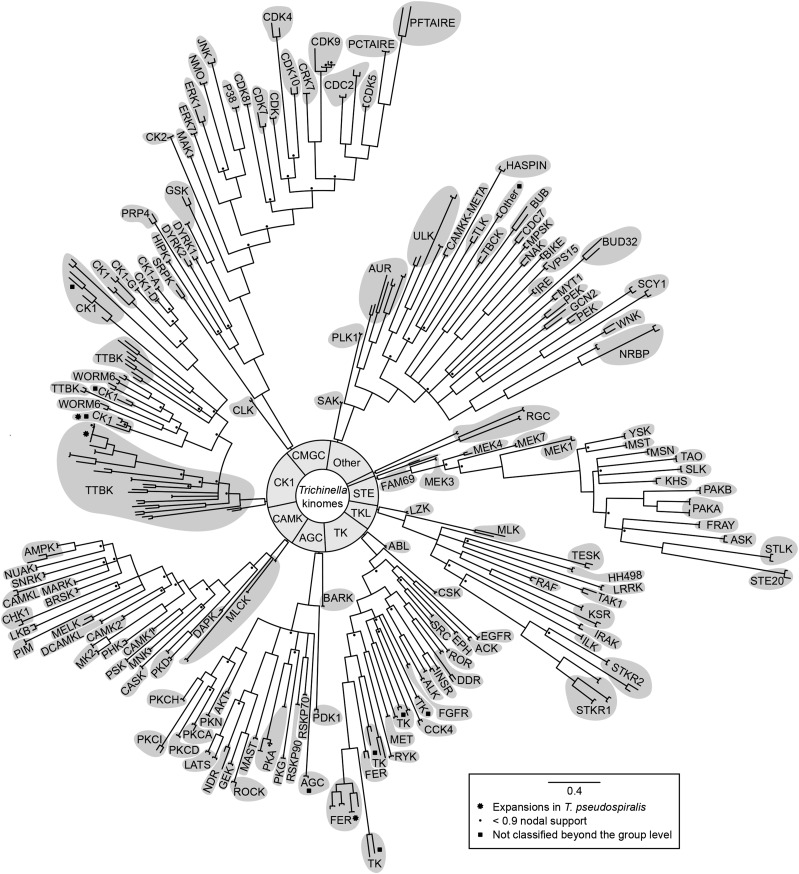
Phylogenetic analyses of eukaryotic protein kinases (ePKs) of Trichinella spiralis and T. pseudospiralis. Phylogenetic trees (Bayesian inference) were constructed based on alignment of amino acid sequences representing individual kinase groups. High-resolution figures of individual trees, including nodal support values and sequence identifiers, are given in Figure S1.